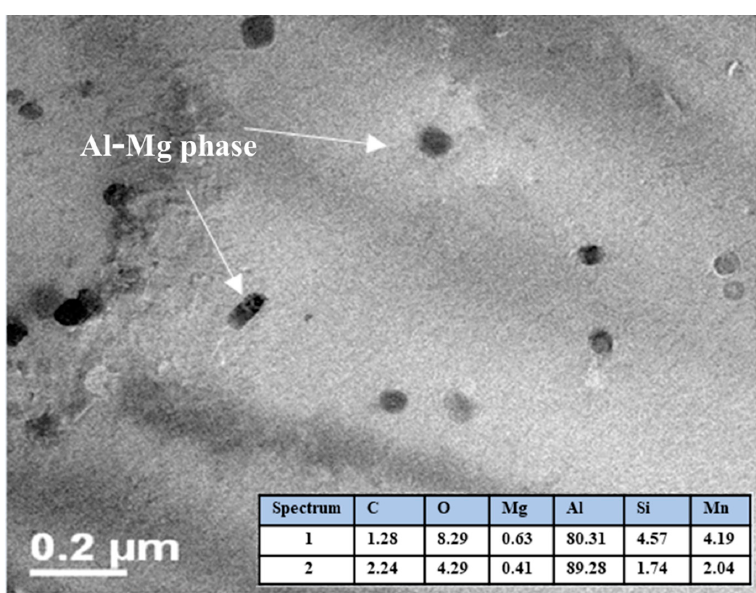
Figure 16. TEM bright field image of the Al/C composite.